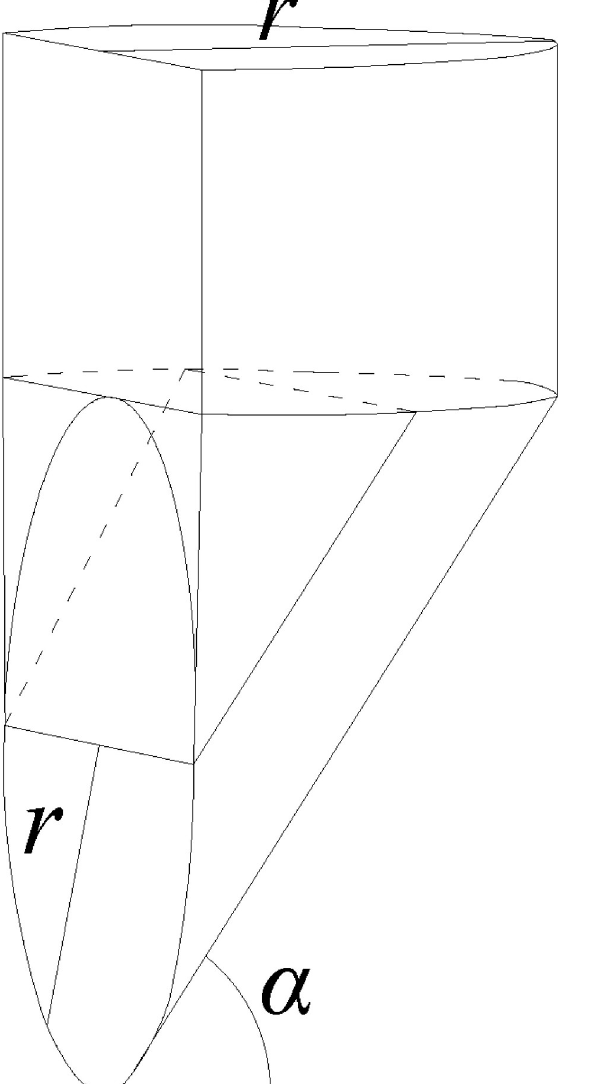
Fig 10. Semicylinder cone-like sliding